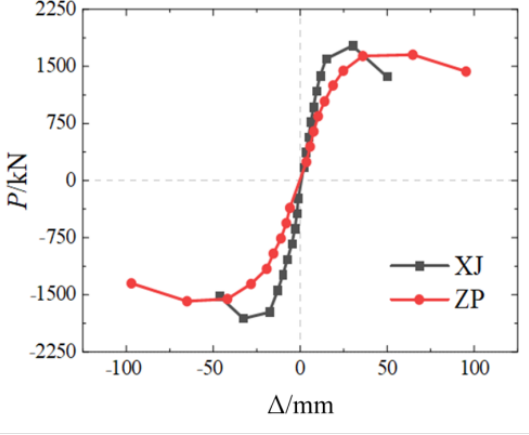
the ductility coefficient is the ratio of damage displacement to yield displacement; initial stiffness is the ratio of 20% of yield load to the corresponding displacement.